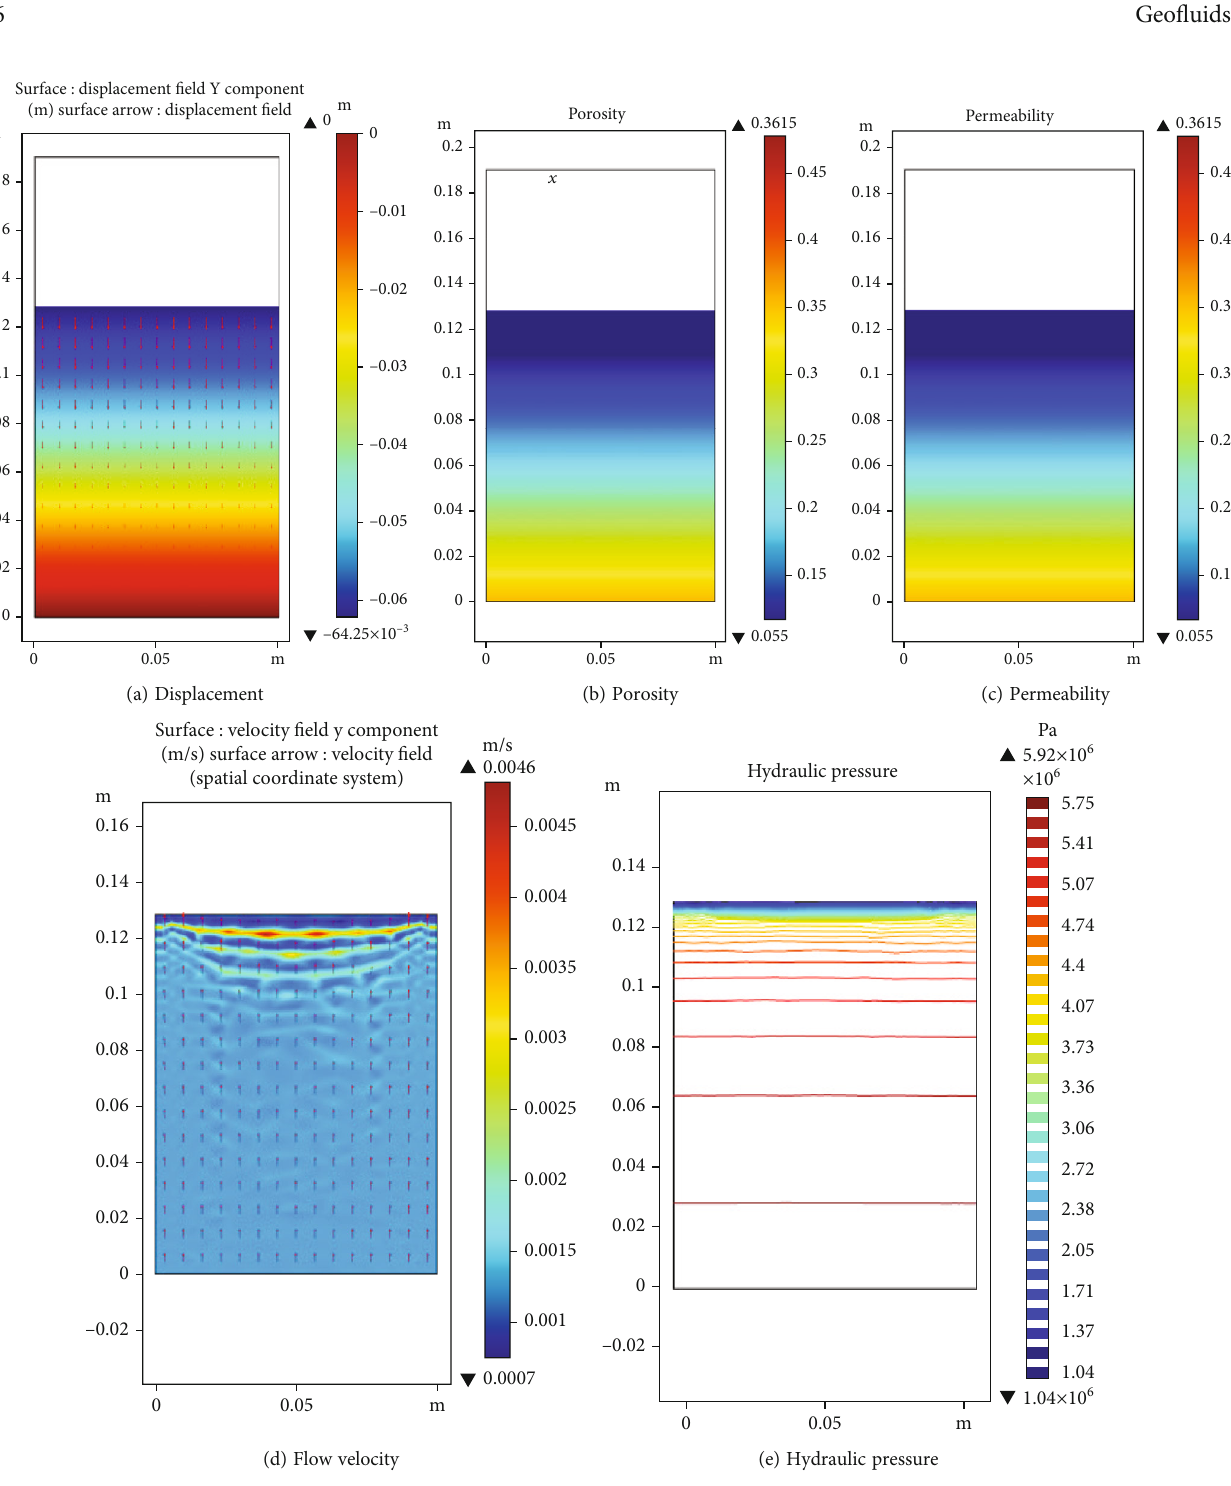
Figure 15: Seepage rules in the gangues with a size range of 0 ~